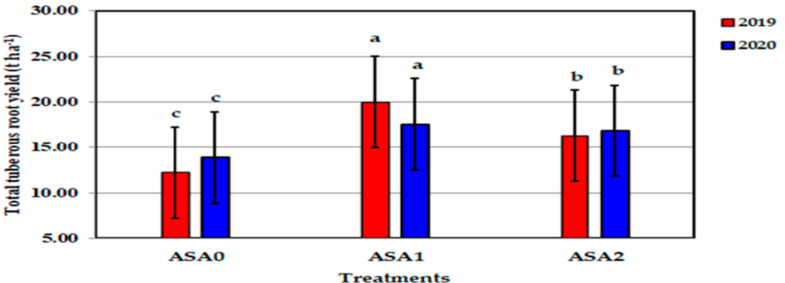
Figure 12. Influence of zinc oxide nanoparticles doses on total tuberous roots yield of sweet potato in 2019 and 2020 seasons. Bars with a different letter indicate significant difference between treatments at p ≤ 0.05.